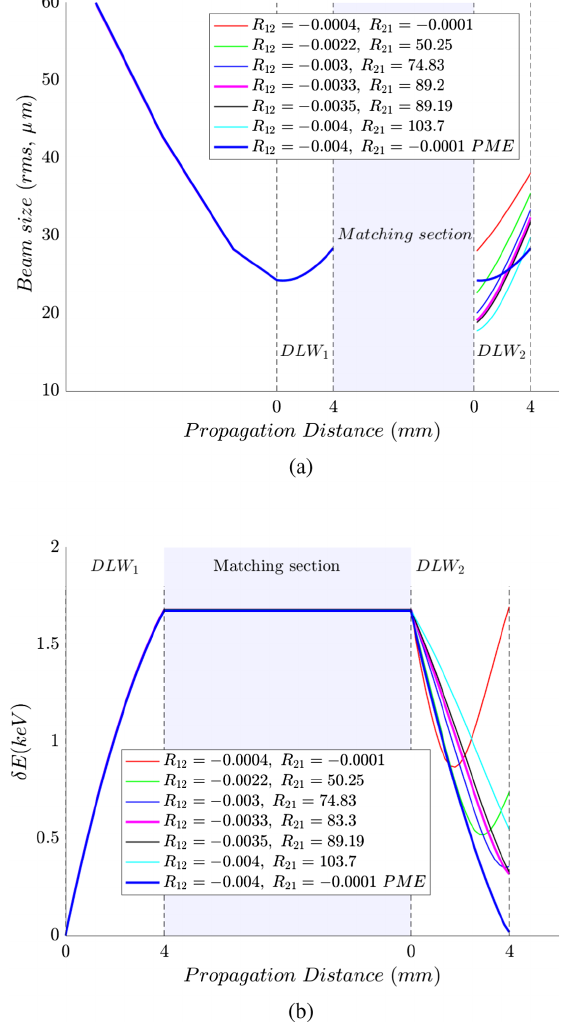
FIG. 12. (a) The beam envelope focused at the entrance of DLW 1 and across DLW 2 after the matching section resulting from each solution presented in Table I. (b) The increase of energy spread due to the correlation with the longitudinal quadrupole component of the THz field in DLW 1 and recovery of this correlated energy spread in DLW 2 corresponding to a different solution for the matching section.